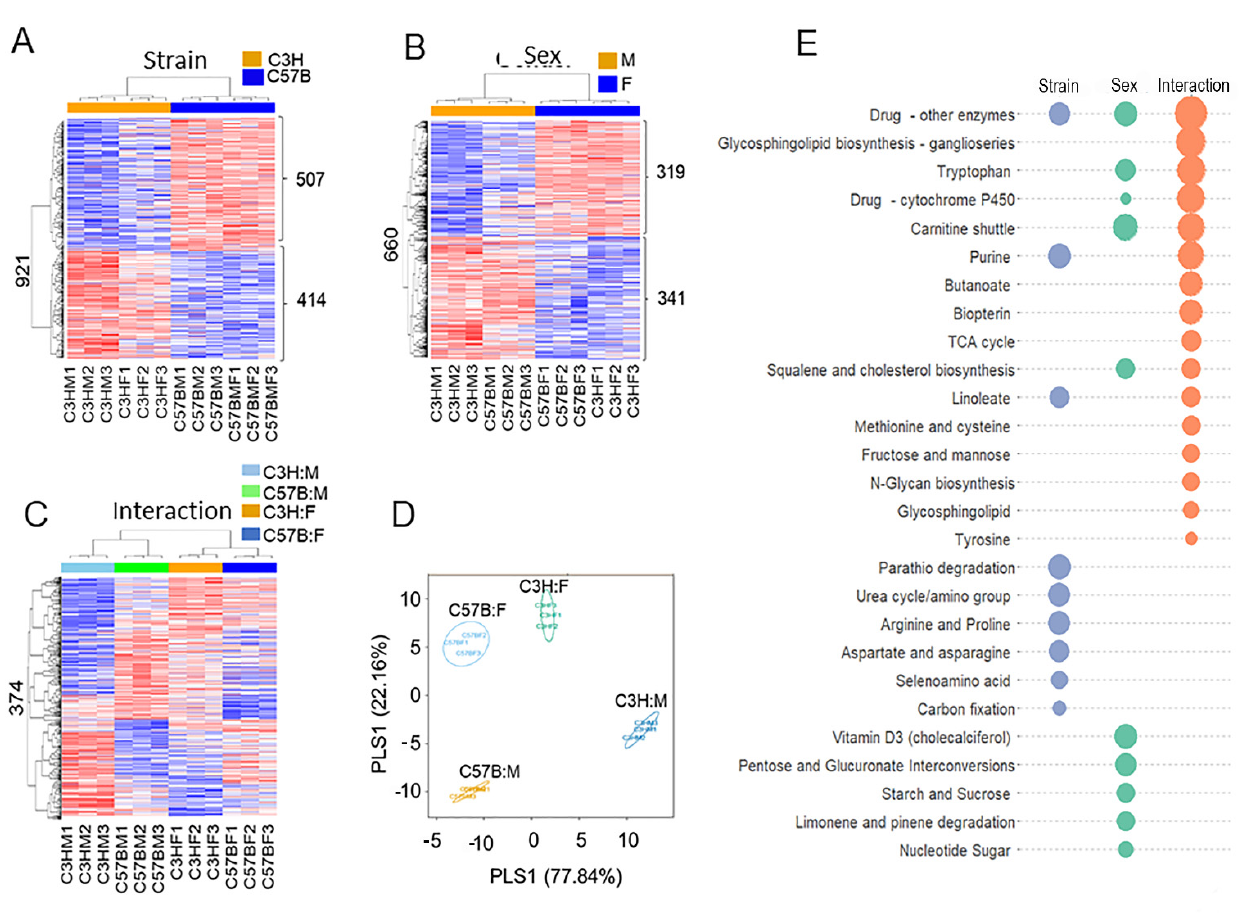
Figure 1. Differentially expressed metabolites. The results of two-way hierarchical clustering pre- sented as heatmaps for ( A ) strain, ( B ) sex, and ( C ) interactions. ( D ) PLS-DA score plot for high- resolution metabolomics data resulting in strain, sex, and interaction. ( E ) Pathway enrichment analyses among strain, sex, and interactions as a bubble plot with bubble size corresponding to the size of the log value ( p < 0.05).